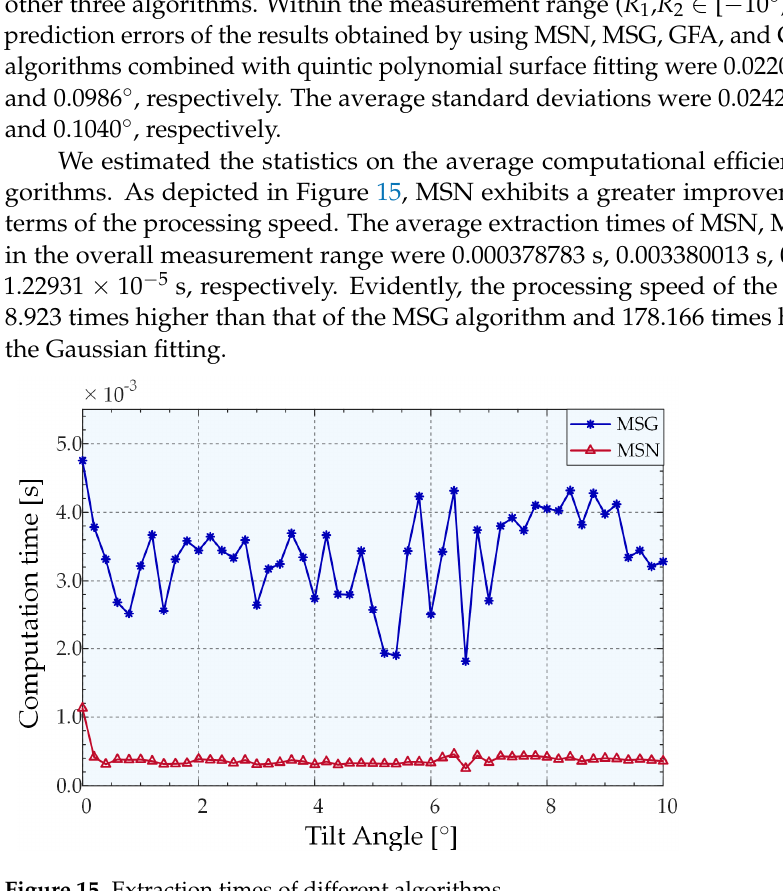
Figure 16. Angle prediction errors for different fitting strategies.